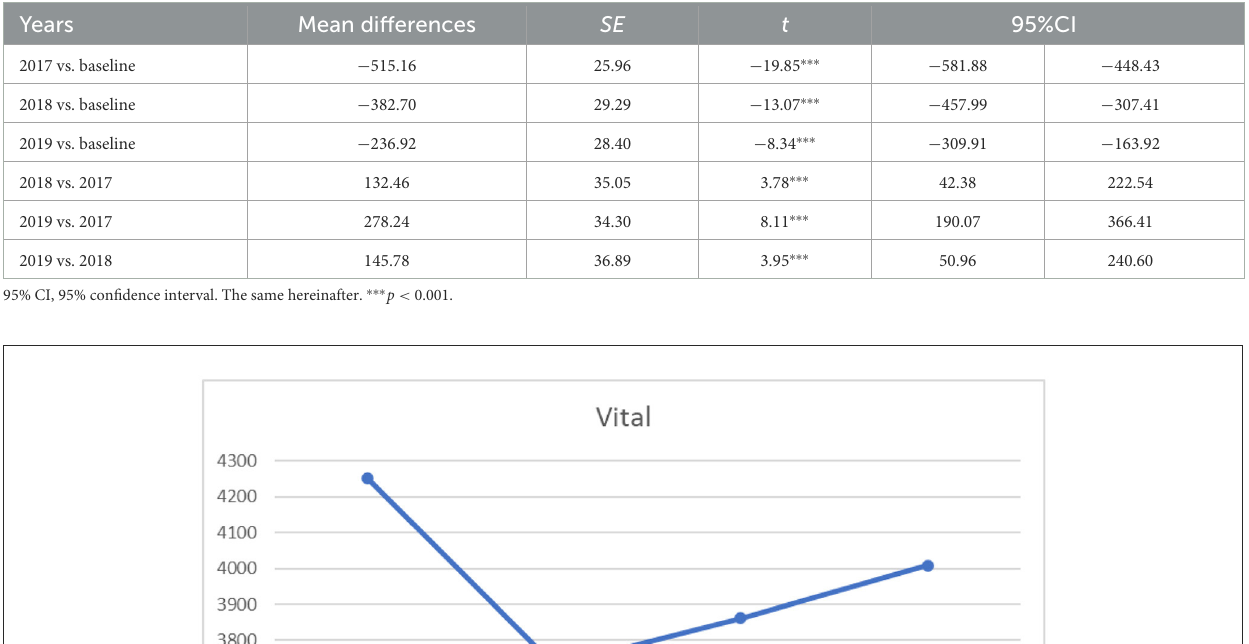
TABLE 3 Multiple comparisons: mean differences and confidence intervals for vital capacity across mean baseline (2013–2016), 2017, 2018, and 2019.